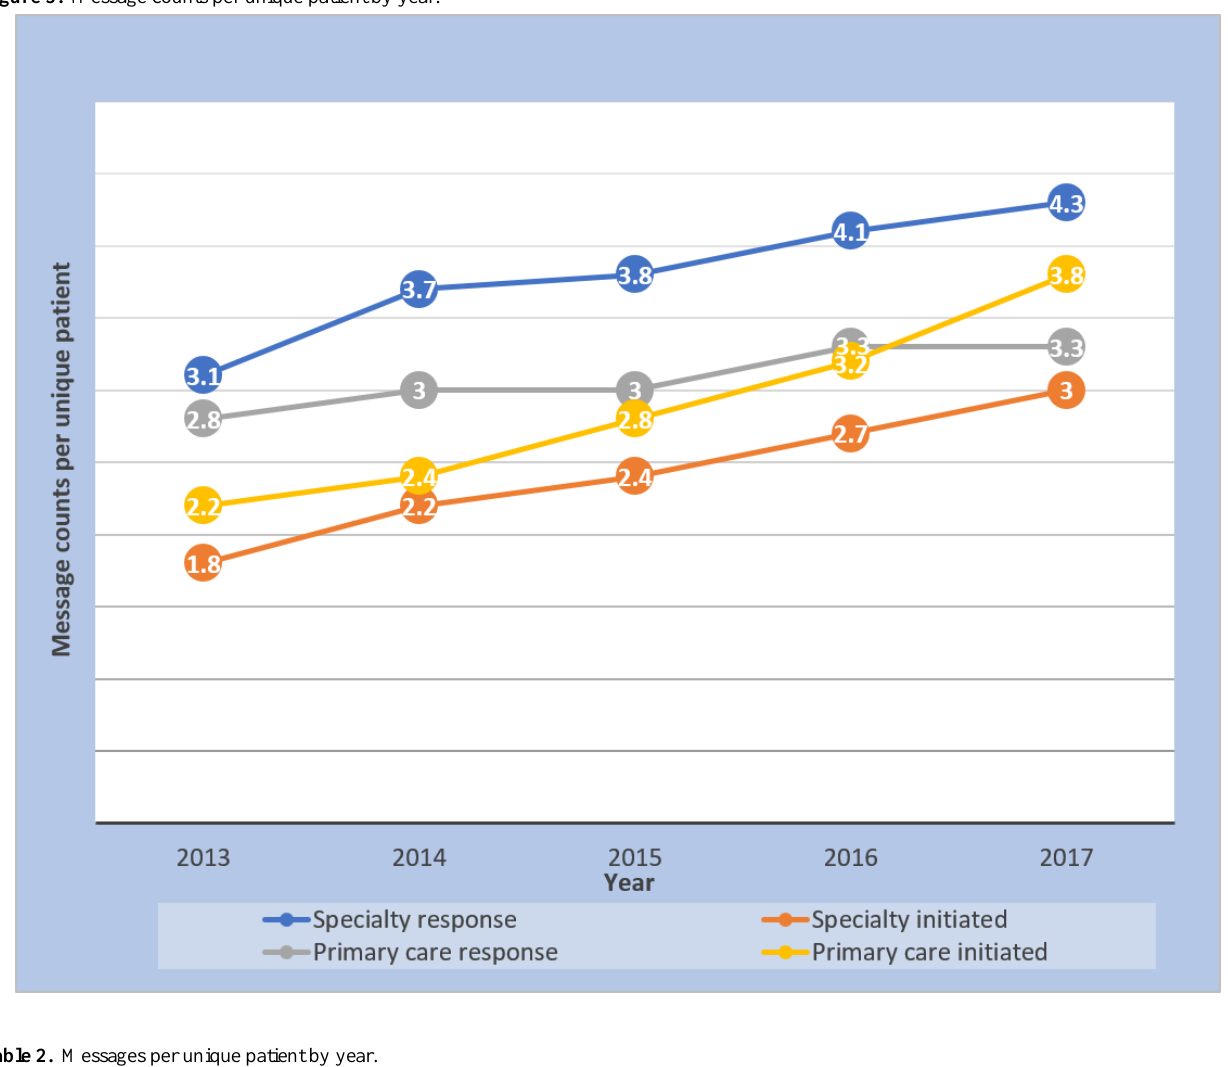
Figure 3. Message counts per unique patient by year.